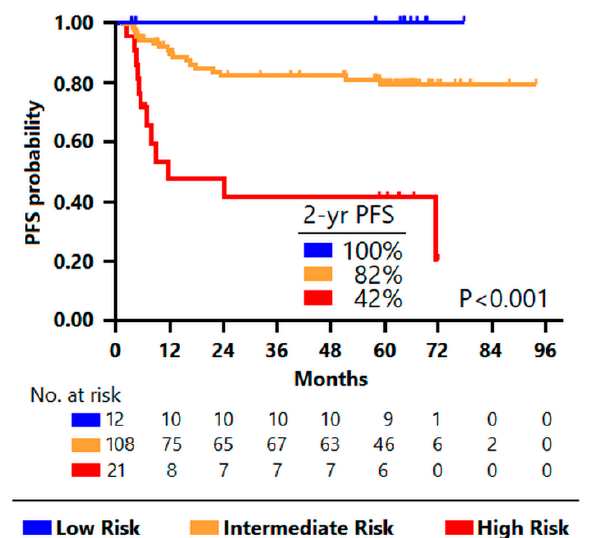
Figure 3. Kaplan–Meier progression-free survival estimates according to the integrative PET model derived from the classification tree. The blue curve shows survival of low-risk patients, the yellow curve, of intermediate-risk patients, and the red one, of high-risk patients. Notably, 89% of the high-risk patients had a non-favorable mutational profile.